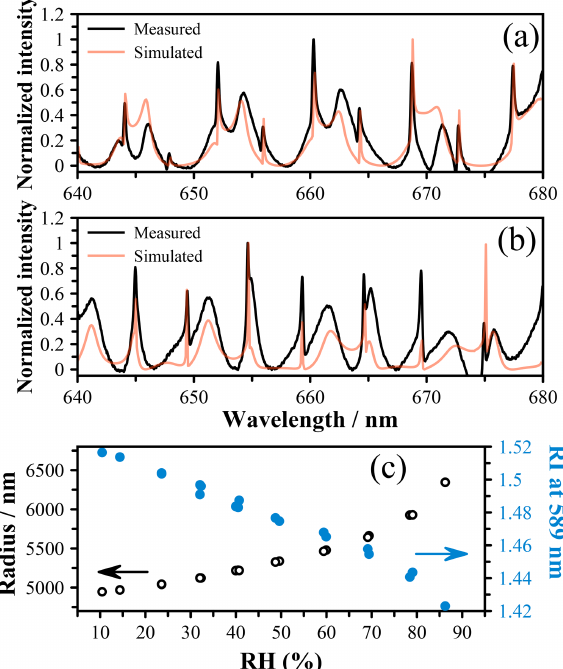
Figure 5. Measured spectra for a droplet of citric acid at (a) high RH ( ∼ 85%) with a radius of 6328nm and an RI of 1.4225 as well as (b) low RH ( ∼ 10%) with a radius of 4954nm and an RI of 1.5175. Both spectra are shown with the Mie theory simulation using these values as inputs. (c) The size and RI of a citric acid droplet as a function of RH determined using an LiCl probe. The arrows indicate the appropriate axis for each